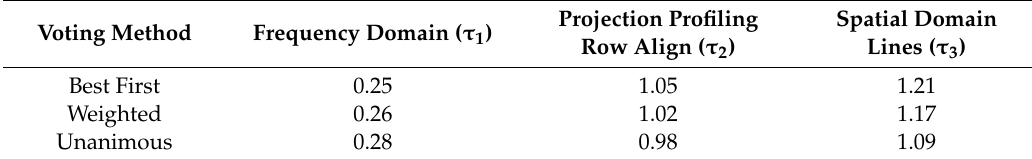
Table 2. Brute-force fine-tuning exponent search